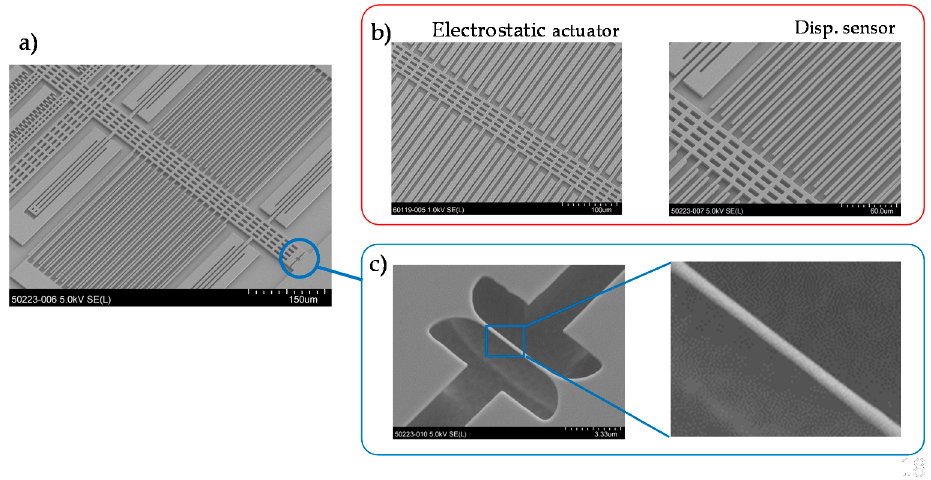
Figure 5. Fabricated device. ( a ) Center moving part with the displacement sensor supported by the suspending beams. The electrostatic actuator is located upper left of this image. ( b ) Close-up view of the electrostatic actuator and the displacement sensor. ( c ) Close-up view of the SiNW specimen.